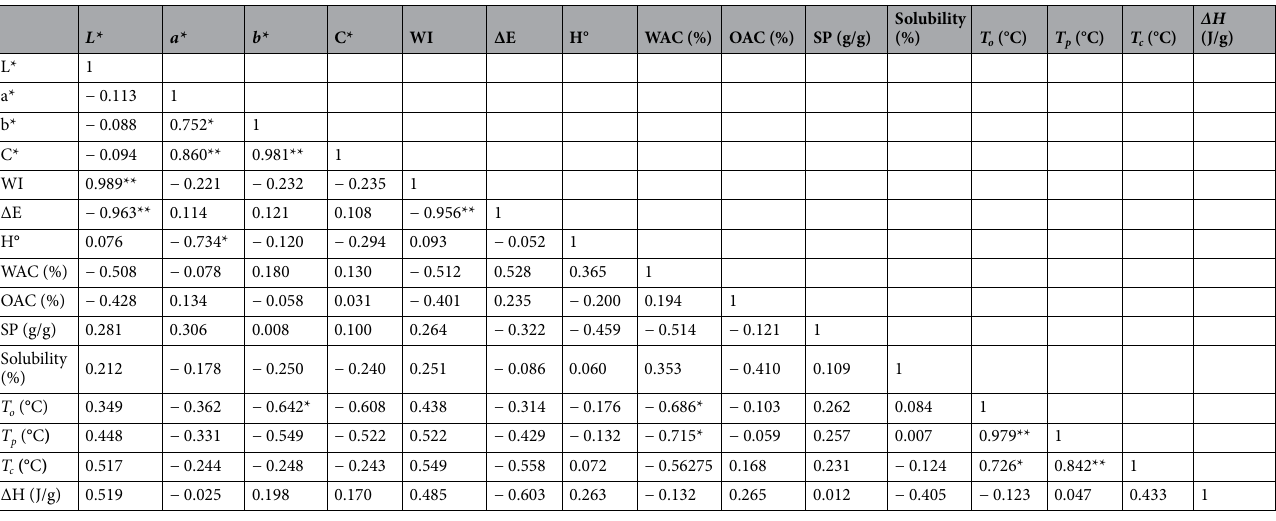
Table 10. Correlation matrix of colour, functional and thermal properties of HMT 15 Bambara groundnut starch. WAC: water absorption capacity; OAC: oil absorption capacity; SP: swelling power; ∆H: gelatinization enthalpy; ∆E: total colour difference; WI: whiteness index; L* : lightness/whiteness; a* : yellowness/redness; b* : blueness/greenness; C*: chroma; H°: hue; T o : onset temperature; T p : peak temperature; T c : conclusion